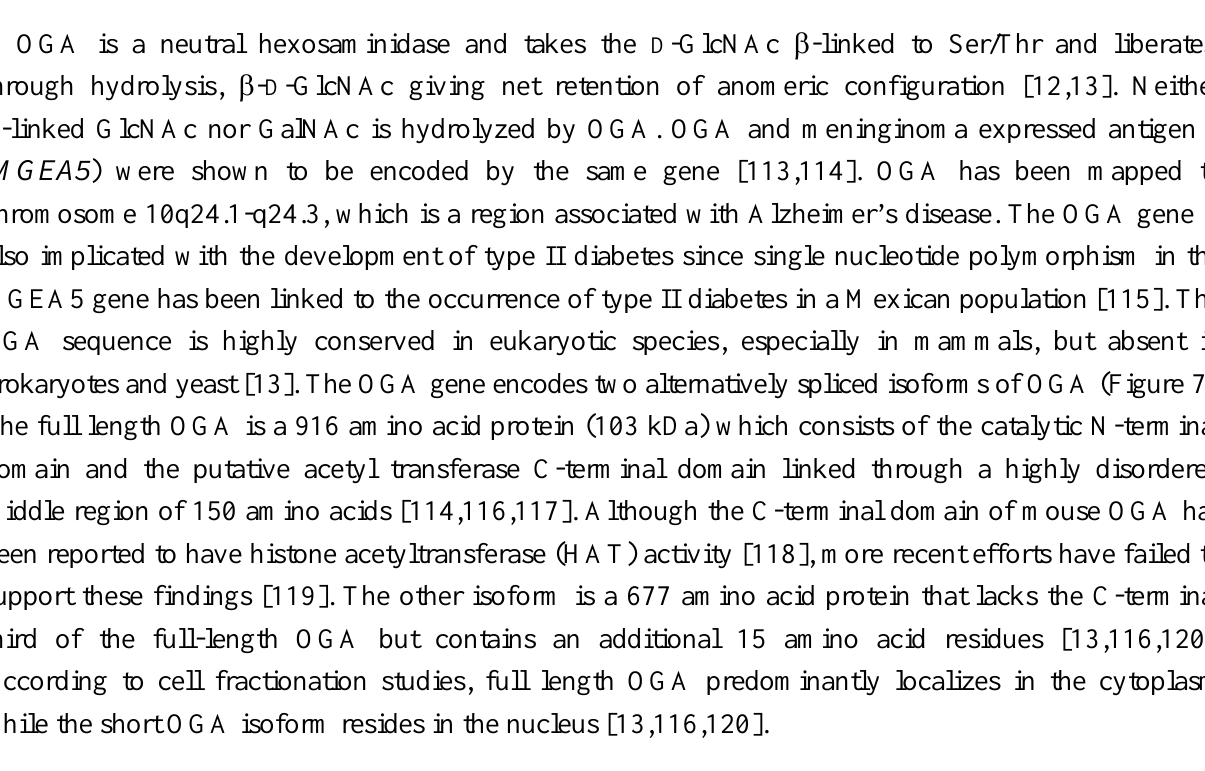
Figure 7. Human OGA